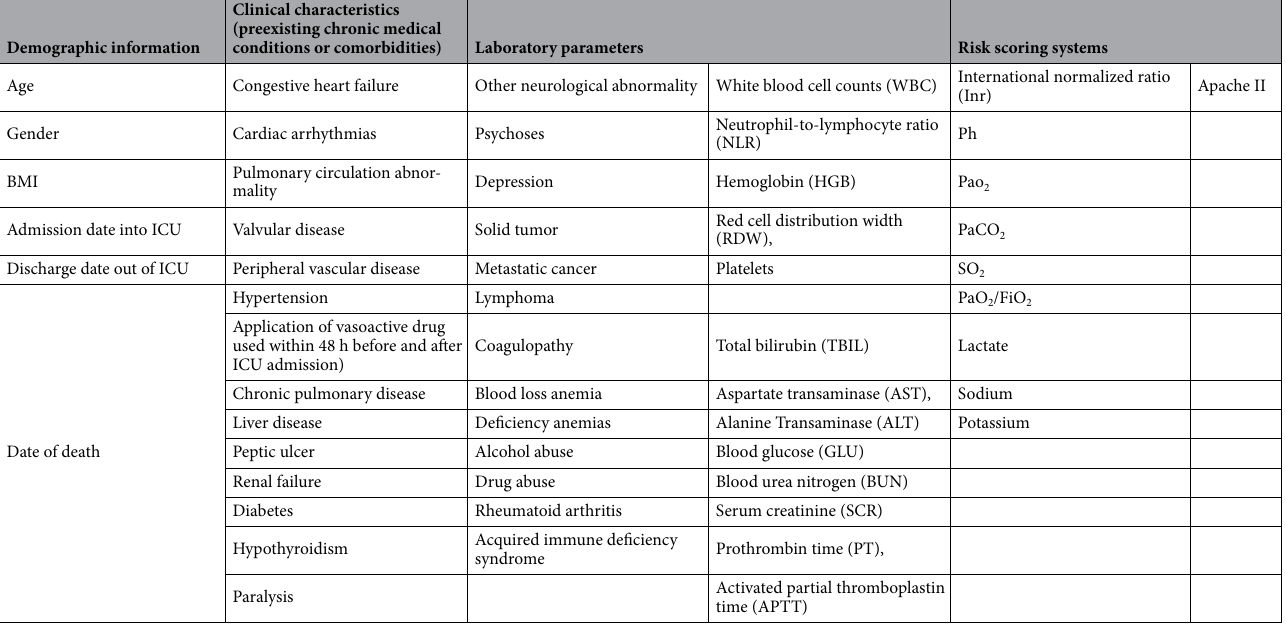
Table 2. Demographic, clinical, laboratory and risk scoring systems extracted from the